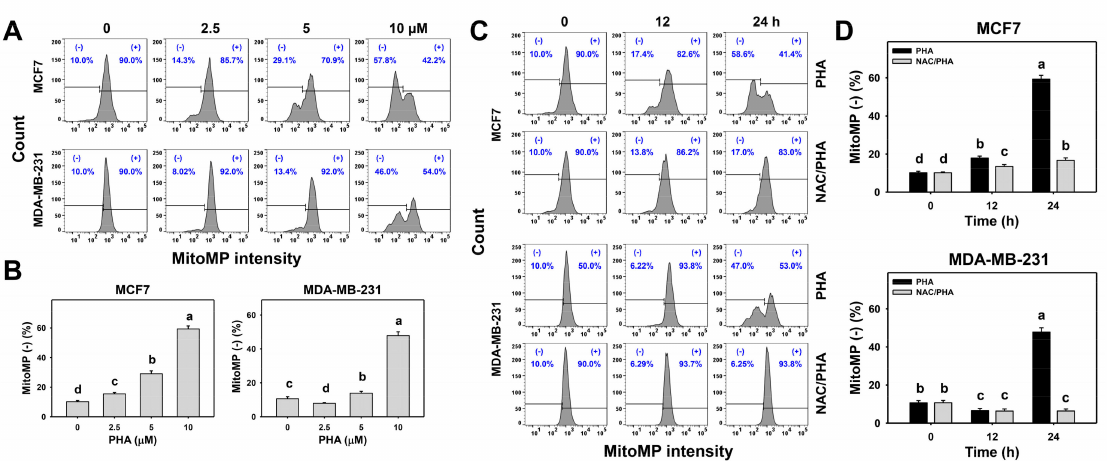
Figure 6. PHA triggered MitoMP depletion in two breast cancer cell lines. ( A , B ) MitoMP patterns and statistical analysis for concentration responses to PHA. Cells were incubated with PHA (0 (0.05% DMSO as control), 2.5, 5, and 10 µ M) for 24 h. ( − ) indicates MitoMP ( − ) (%). ( C , D ) Patterns and statistical analysis of NAC pretreatment responses in MitoMP changes in PHA-post-treated breast cancer cells. Following pretreatment with NAC, cells were processed with post-treatment for 0 (control with 0.05% DMSO) and 10 µ M PHA for 0, 12, and 24 h, i.e., PHA and NAC/PHA. Data, means ± SDs ( n = 3 independent experiments). Experiments without the same top-labeled letters indicate significant changes according to multiple comparisons ( p < 0.005 to